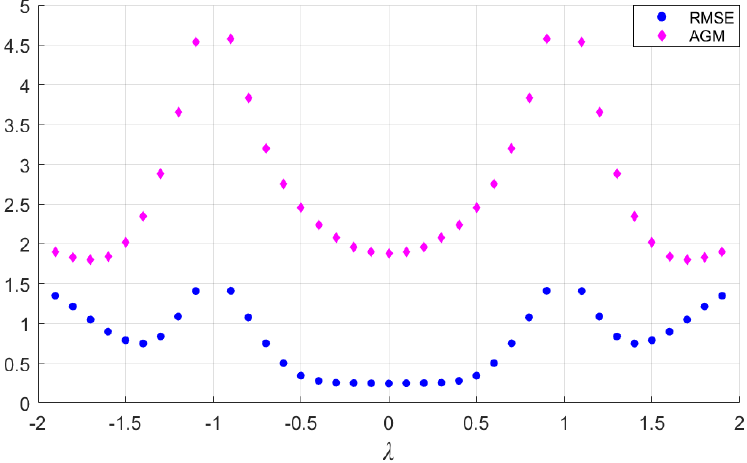
Figure 3. RMSE and AGM of CT images reconstructed by basic filters with different λ ( λ = ν /10, ν ∈ Z and λ / ∈ Z \{ 0 } ).